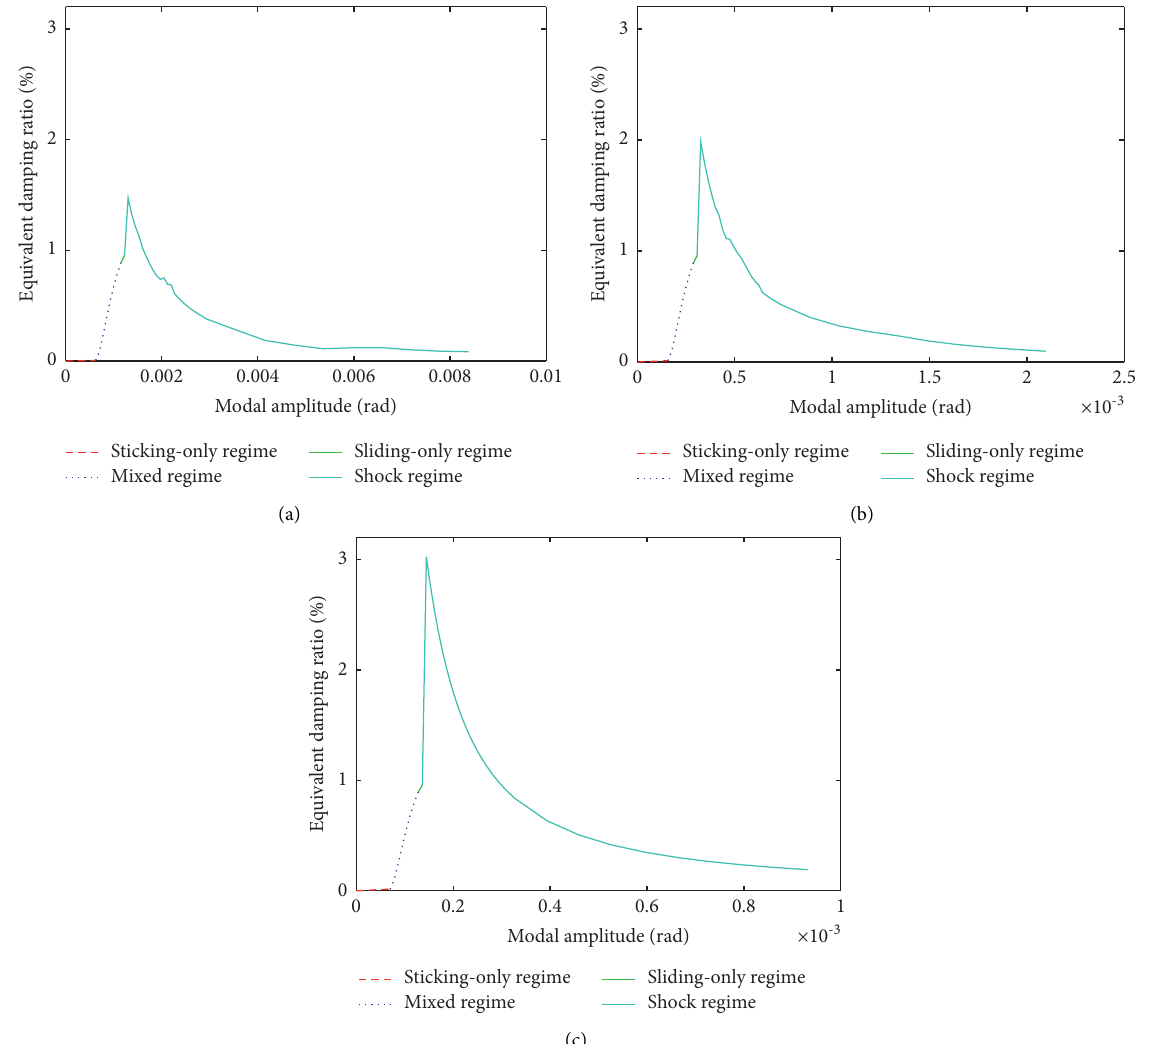
Figure 12: Influence of the natural frequency of the structure on the damping effect of the shock-friction damper (a) f � 130Hz, (b) f � 260Hz, and (c) f � 390Hz with optimized backlash